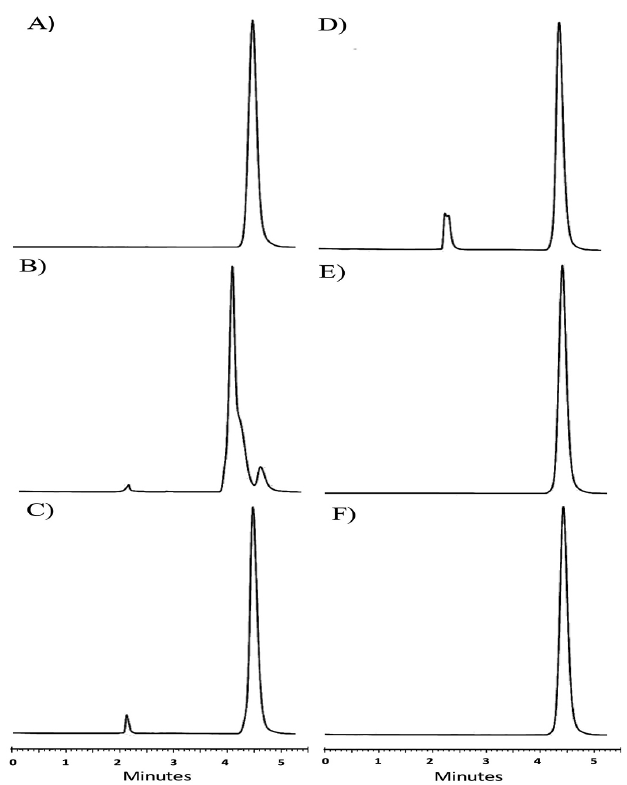
FIGURE 3 - Chromatograms obtained after forced degradation test for 24 h. A) Ferulic acid standard solution - Reference (50 µg/mL) B) After basic hydrolysis (NaOH 1 mol/L) C) After acid hydrolysis (HCl 1 mol/L) D) After oxidation (H exposure to visible light F) After storage at -20 °C.